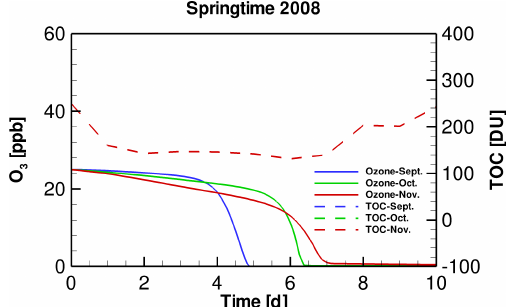
Figure 4. Temporal evolution of tropospheric ozone during ODEs in different months of the springtime of 2008, using a same TOC temporal profile. Note that in this figure, the TOC profiles belong- ing to September, October and November overlap, because they are identical in this sensitivity